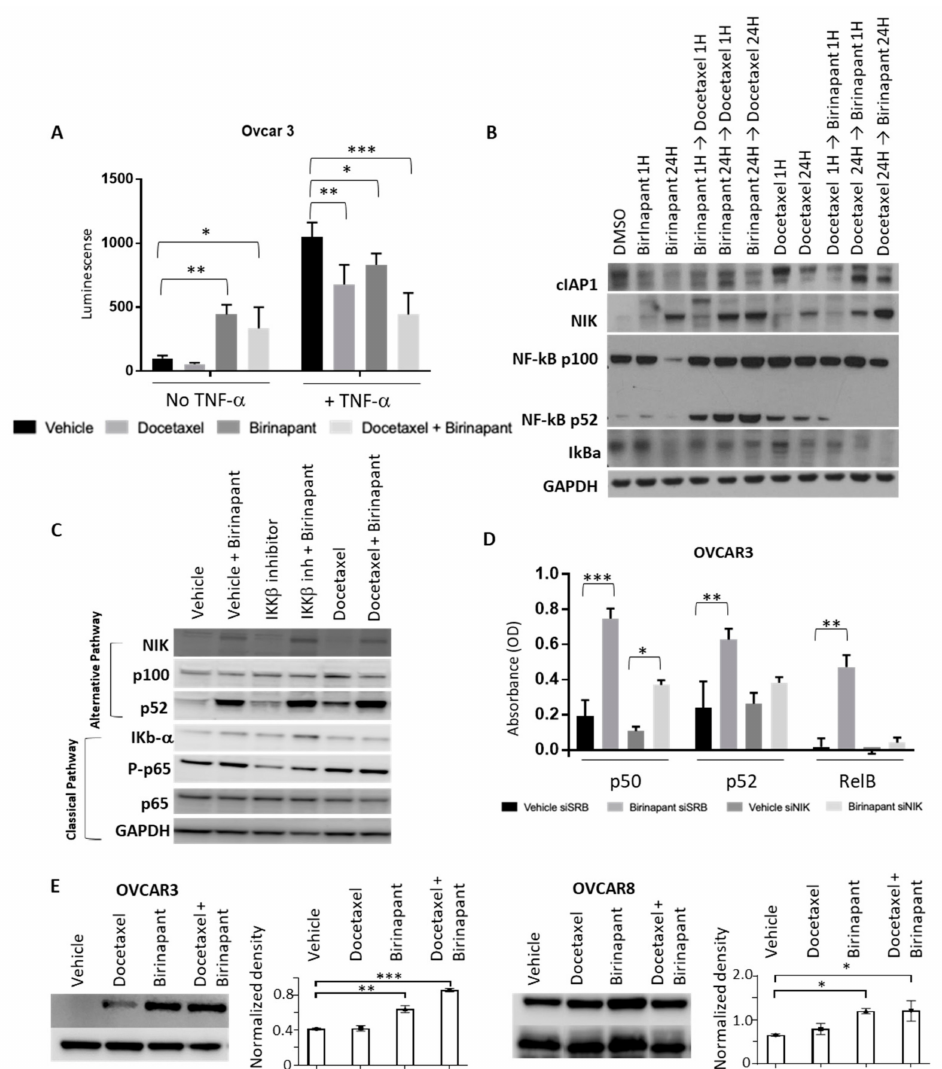
Figure 5. Birinapant suppresses the classical NF-kB pathway and enhances the alternative NF-kB pathway. ( A ) NF-kB signaling was assessed in OVCAR3 cells after establishing a reporter cell line stably transduced with a lentiviral vector containing luciferase under control of NF-kB consensus response element. Reporter cells were treated with single-agent (docetaxel 4, birinapant 400 nM) or combination therapy for 24 h, both with and without exogenous TNF- α (10 ng / mL). * p < 0.05; ** p < 0.001; *** p < 0.0001. ( B , C ) NF-kB alternative and classical pathway proteins were assessed by western blot to determine the e ff ect of birinapant on NF-kB signaling. Cells were treated for 3 h with either single-agent (400 birinapant or 4 nM docetaxel) or concurrent combination therapy prior to western blot analysis. ( D ) Nuclear protein binding of p50, p52, and RelB to NF-kB consensus oligonucleotide was quantified using TransAm NF-kB assay, both with and without NIK knockdown to assess the input of NF-kB alternative pathway activation. Cells were treated with birinapant 400 nM for 1 h prior to analysis. Absorbance reflects density of colorimetric secondary antibody. * p < 0.01; ** p < 0.001; *** p < 0.0001. ( E ) Glu-tubulin, a marker of stable microtubules, was measured by western blot after exposure of OVCAR3 and OVCAR8 cells for 30 min to vehicle, docetaxel 4, birinapant 400, or docetaxel 4, plus birinapant 400 nM. Shown are representative images (left panels). Quantification of duplicate blots (right panels) was performed by densitometry with all values normalized to GAPDH using LI-COR software. * p = 0.05; ** p < 0.01; *** p < 0.001. Error bars in A, D, and E indicate standard error of the